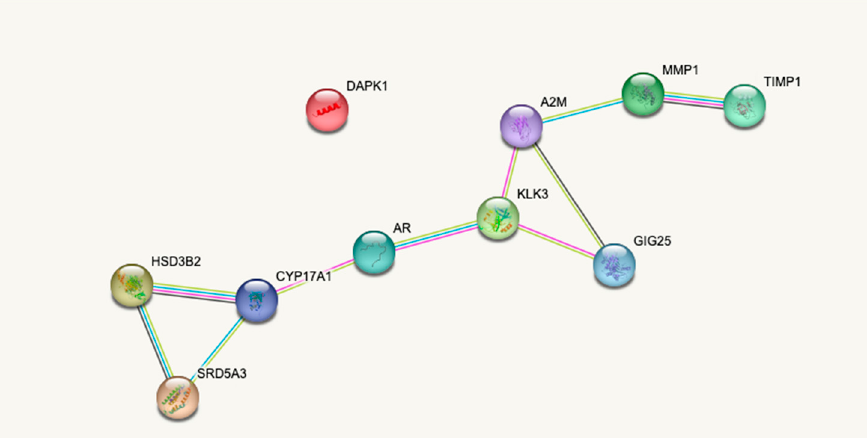
Figure 5. Schematic depiction of the genes involved in the PSE signature. The network was built using the five model markers and PSA, using the STRING DB (https://string ‐ db.org/, accessed be ‐ tween 1 st July and 1 st October 2022). The network was generated by five additional entities that have a high confidence in interaction (data supporting the connections) suggesting high connectability at the protein level. DAPK1 , HSD3B2 , SRD5A3 and MMP1 model markers are circled in blue, PSA (KLK3) in red. miRNA98 is not in STRING.